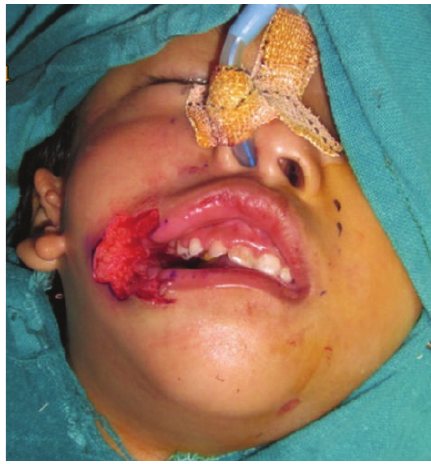
Figure 3: Photograph after flap elevation.